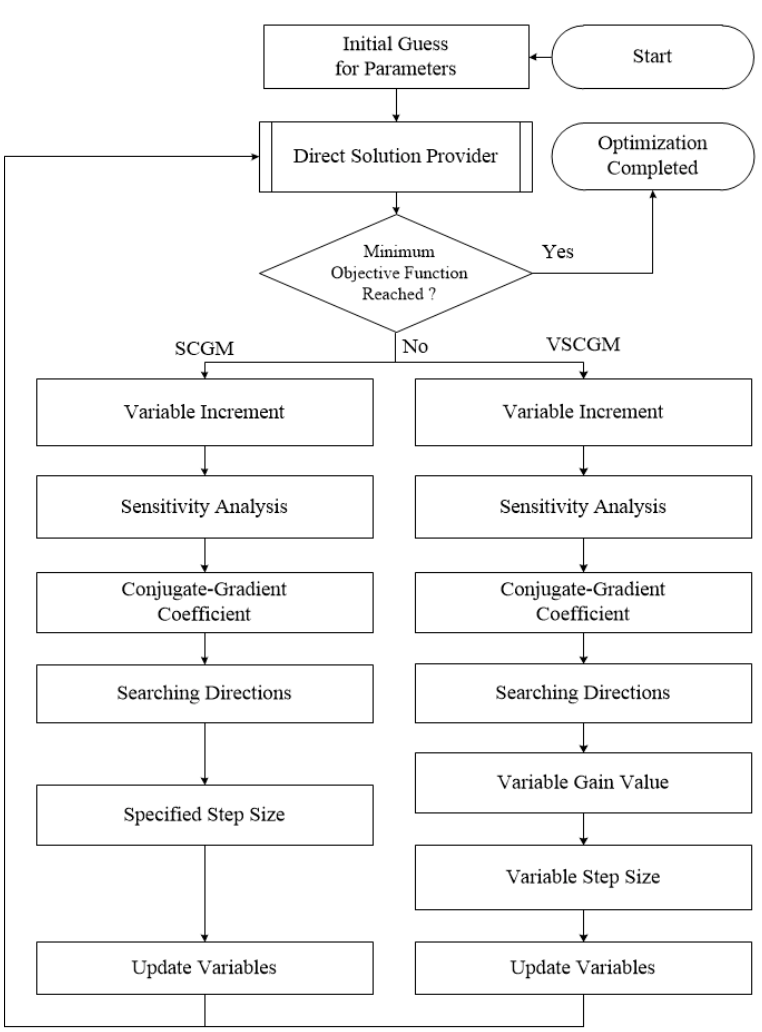
Figure 1. Comparison between variable-step simplified conjugate gradient method (VSCGM) and simplified conjugate gradient method (SCGM) methods. simplified conjugate gradient method (SCGM)